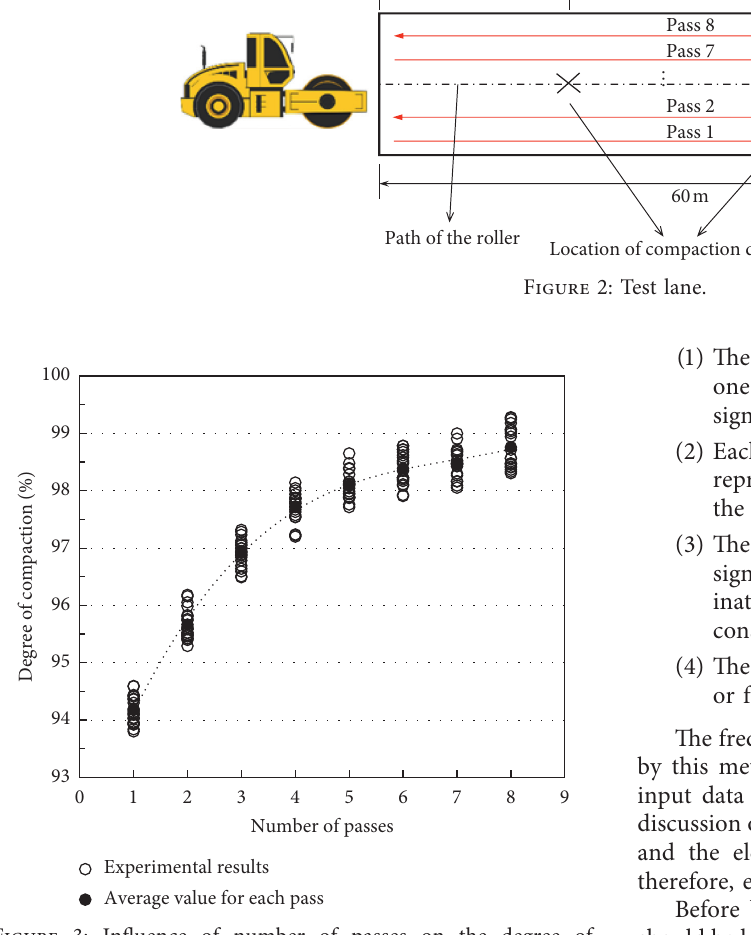
Figure 3: Influence of number of passes on the degree of